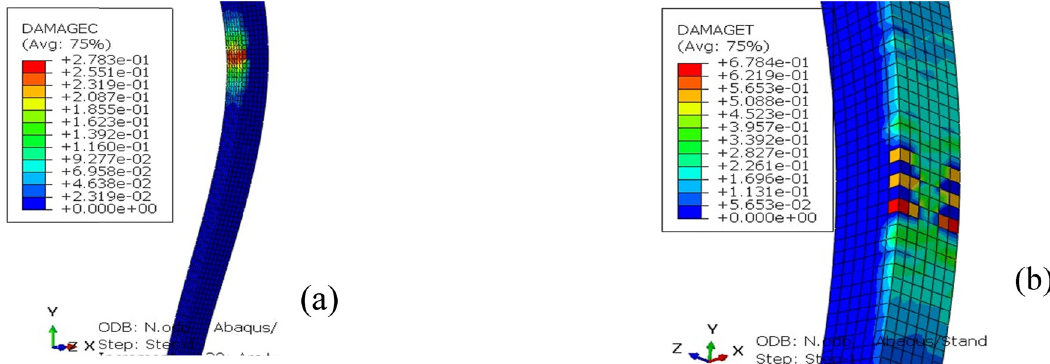
Figure 10: Damages in Model No. 2: ( a ) compression damage and ( b ) tension